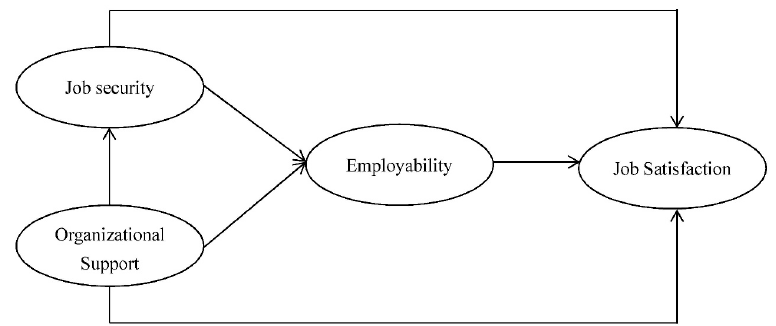
Figure 1. Research Figure 1. Research framework.